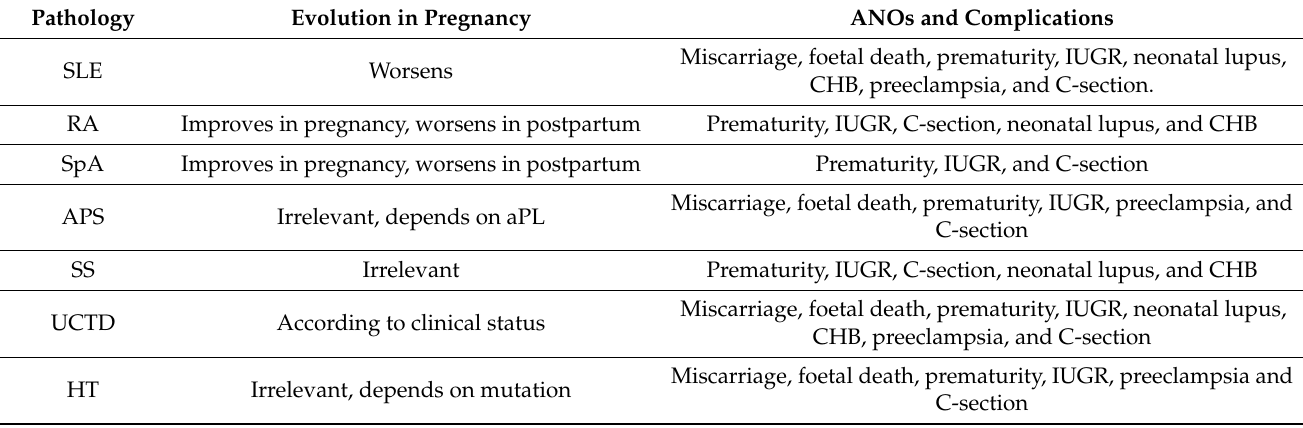
Table 1. Rheumatic diseases and hereditary thrombophilia evolution during